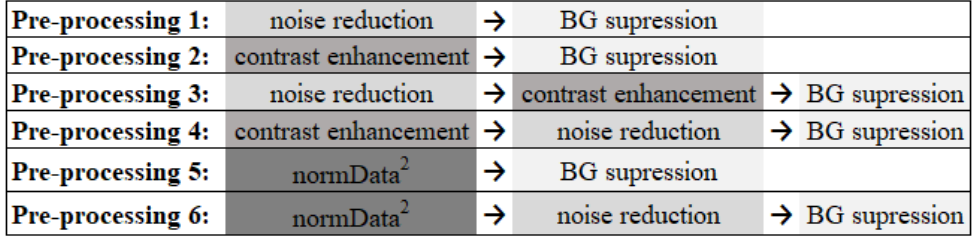
Figure 1. The six preprocessing methodologies implemented in order to reduce noise and amplify the visibility of the MCs (BG: background, normData: data normalized between 0 and